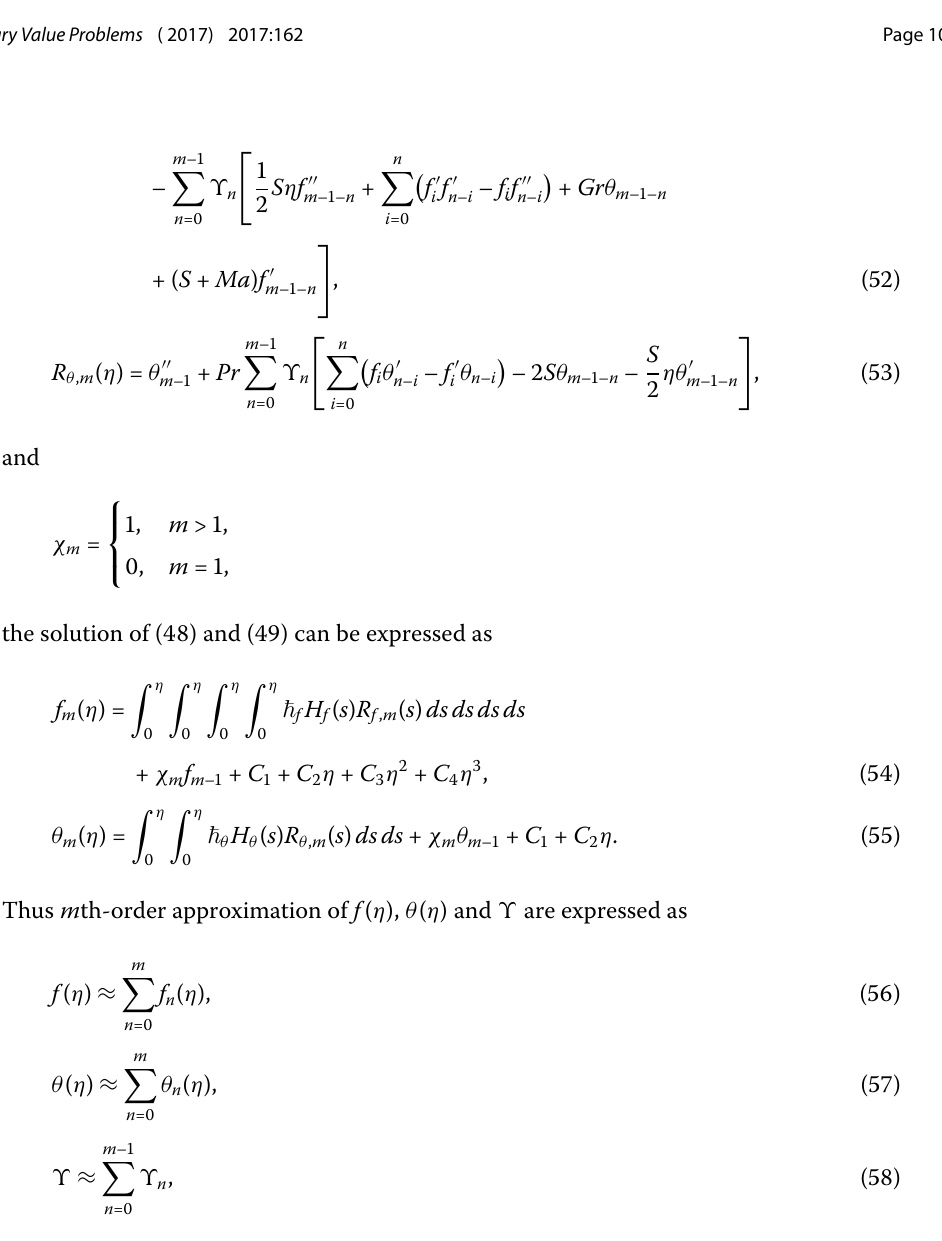
Table 1 Optimal value of convergence control parameters versus different orders of approximation Order of approximation